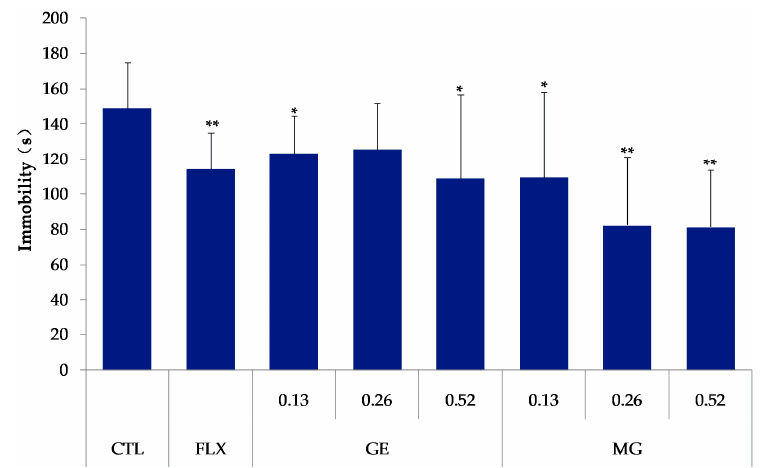
Figure 6. Effects of GE or MG on the immobility time in the forced swim test. The mice were treated orally with MG and GE at 0.13, 0.26, or 0.52 mmol/kg/day, and fluoxetine (FLX) at 20 mg/kg/day for 7 days. The bars indicate the mean ± SD ( n = 10). * p < 0.05, ** p < 0.01 compared with the control group (CTL).